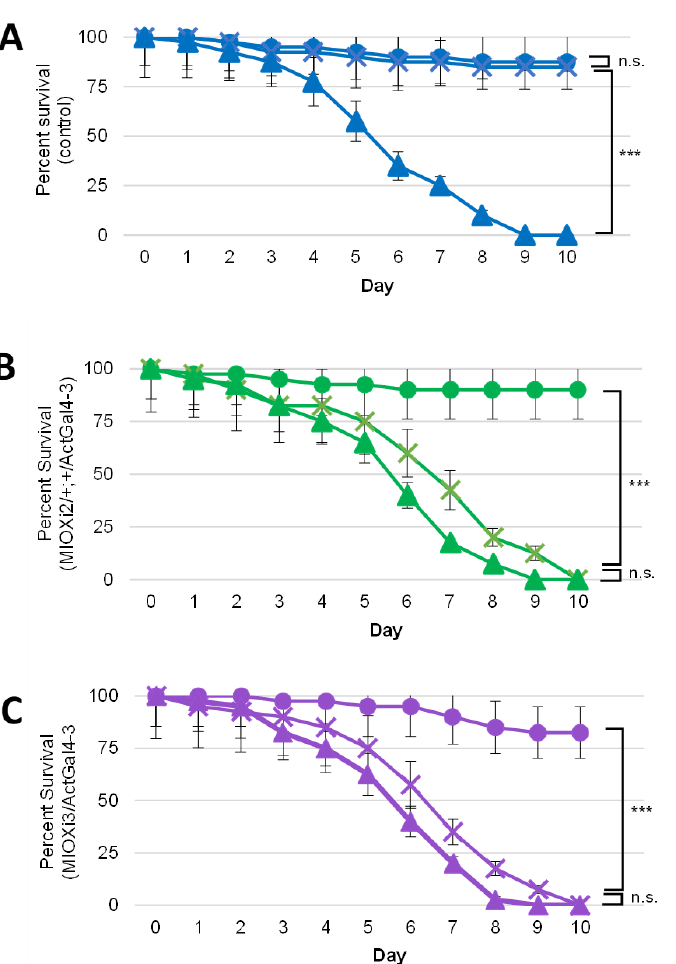
Figure 2. Wild-type (CS) D. melanogaster adults, but not MIOX i 2 / + ; + / Act5CGal4-3 and MIOXi3 / Act5CGal4-3 adults, are viable on food with myo- inositol as the sole sugar (CAA-I). On CAA-S, all the strains survive, and without sugar (CAA-0), all the strains die. Survivals on three foods are displayed: CAA-S ( • ), CAA-I (x), and CAA-0 ( ▲ ). ( A ) Wild-type control strain Canton S. ( B ) MIOX i2/+; +/Act5CGal4-3. ( C ) MIOX i3/Act5CGal4-3. Mean ± SE of six independent trials with twenty